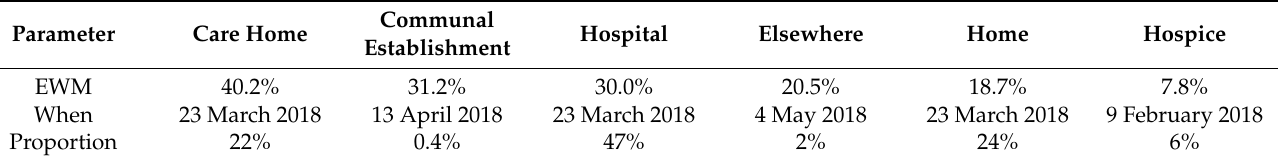
Table 6. Effect of place of death on EWM for the winter of 2017/18 in England and Wales, weekly data. Communal Parameter Care Home Establishment